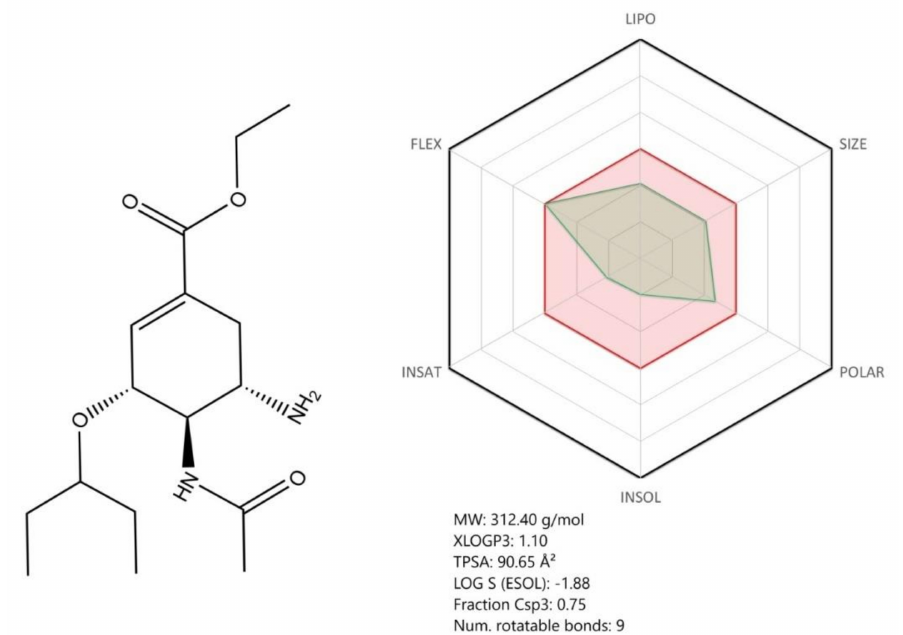
Figure 10. Chemical structure of oseltamivir ADME profile was achieved using the free web tool SwissADME; the red highlighted area represents the suitable physicochemical space for oral bioavailability covering value intervals for the following: LIPO (lipophility): − 0.7 < XLOGP3 < + 5.0, SIZE: 150 g / mol < MV < 500 g / mol, POLAR (polarity): 20Å 2 < TPSA < 130Å 2 , INSOLU (insolubility): 0 < Log S (ESOL) < 6, INSATU (insaturation): 0.25 < Fraction Csp3 < 1, FLEX (flexibility): 0 < Num. rotatable bonds < 9, whereas the overlapped green highlighted area shows the calculated ADME profile for the molecule [63].